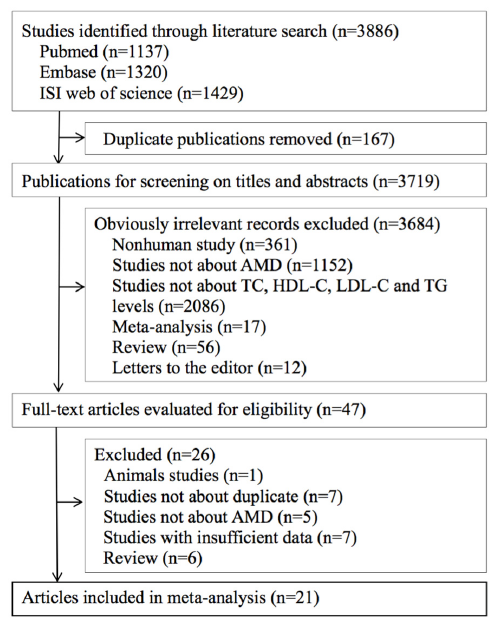
Figure 1. Flowchart for the selection of eligible studies. AMD, age ‐ related macular degeneration.